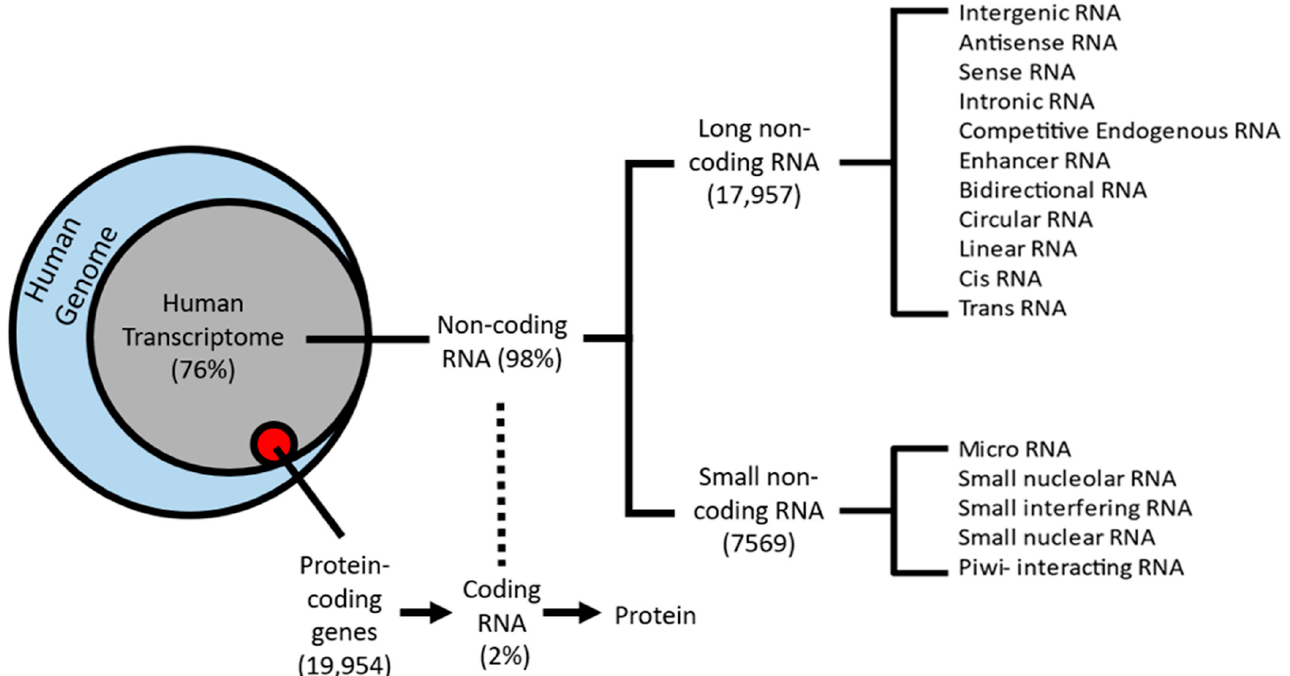
Figure 1. Schematic classification of the human transcriptome: 76% of protein-coding genes from the human genome (blue circle) are transcribed into RNA (gray circle), whereas only 2% (red circle) are translated into functional proteins. The remaining 98% are known as non-coding RNA. Two sub-classes emerge from non-coding RNA: small non-coding RNA (sncRNA) and long non-coding RNAs (lncRNAs).